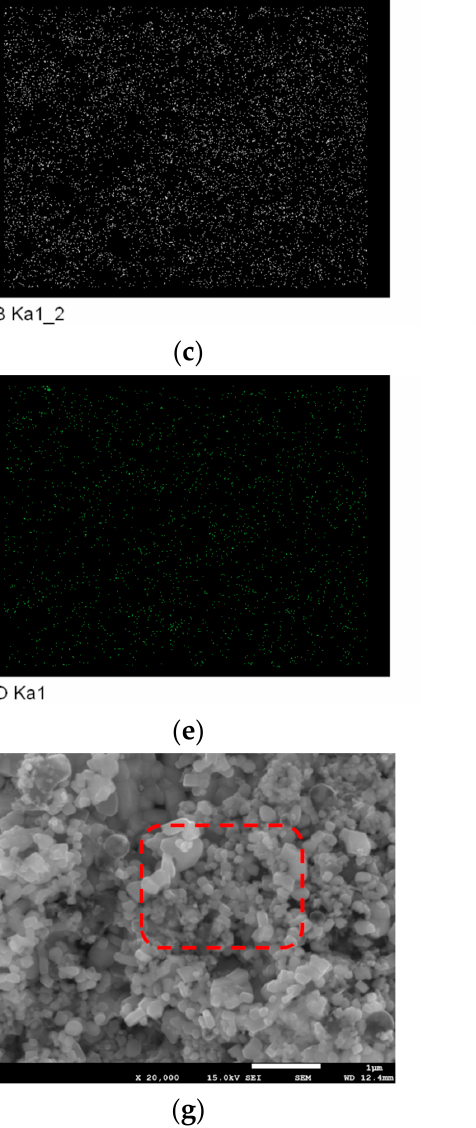
Figure 7. FESEM picture ( a ) and the corresponding EDS maps ( b : Zr; c : B; d : C; e : O) of the RF thermal